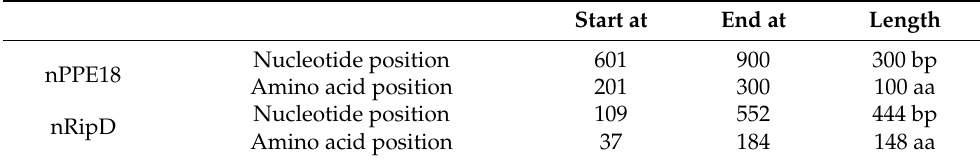
Figure 2. Distribution of T-cell epitope-rich domains in genes of PPE18 ( A ) and RipD ( B ). Abbrevia- tion: aa, amino acids. Table 1. Nucleotide and amino acid positions of nPPE18 and nRipD enriched with T-cell